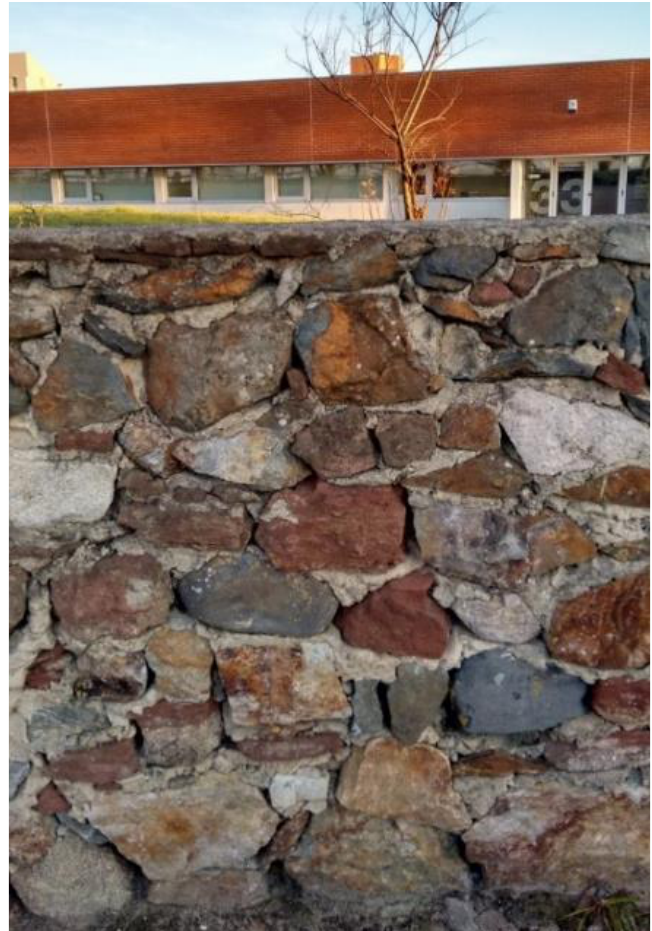
Figure 7. Station 4 overview, where it is possible to observe various types of rocks.